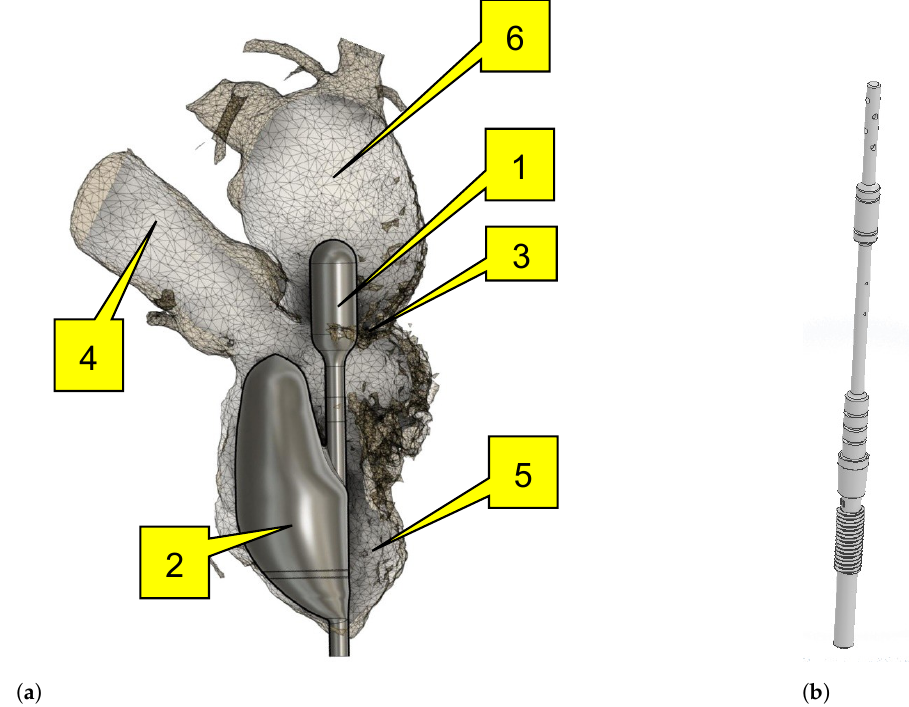
Figure 1. ( a ) Left ventricular assist device in the left heart: (1)—valve balloon, (2)—ventricular balloon, (3)—mitral valve, (4)—aorta, (5)—left ventricle, (6)—left atrium; ( b ) single pneumatic line.